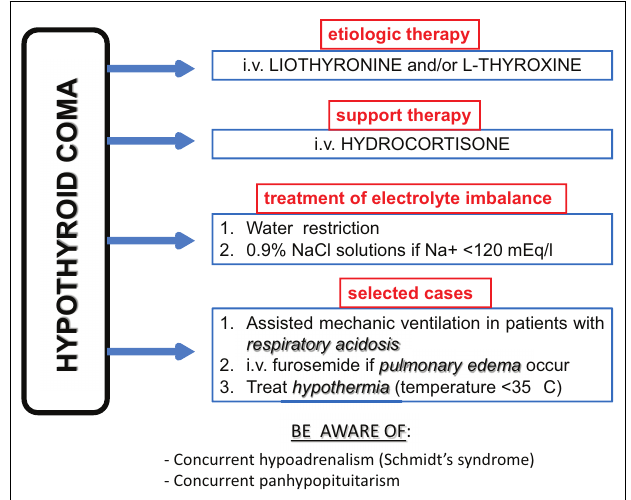
FIGURE 1 | Flow-chart of therapeutic approach to hypothyroid coma